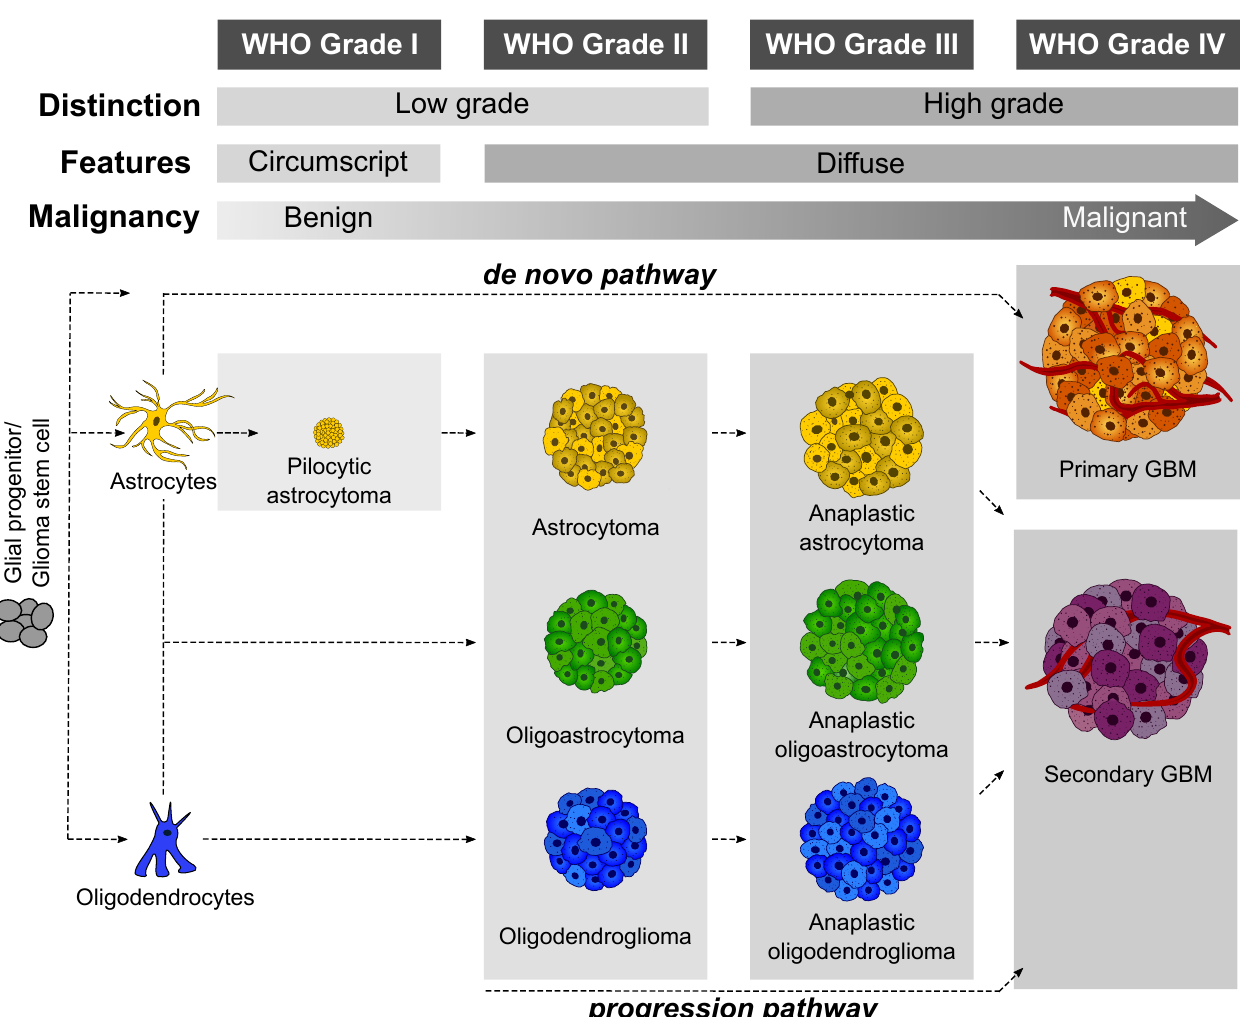
Figure 2. The four glioma grades and their cells of origin as defined by the World Health Organization (WHO, Geneva, Switzerland). Gliomas are characterized on the basis of glial cell types present in the tumor. Tumors arising from astrocytes are called astrocytomas and those originating from oligodendrocytes are called oligodendrogliomas. Tumors consisting of both astrocytes and oligodendrocytes are called oligoastrocytomas. Primary glioblastomas arise mainly from astrocytes and lower-grade gliomas may transform into more aggressive, secondary